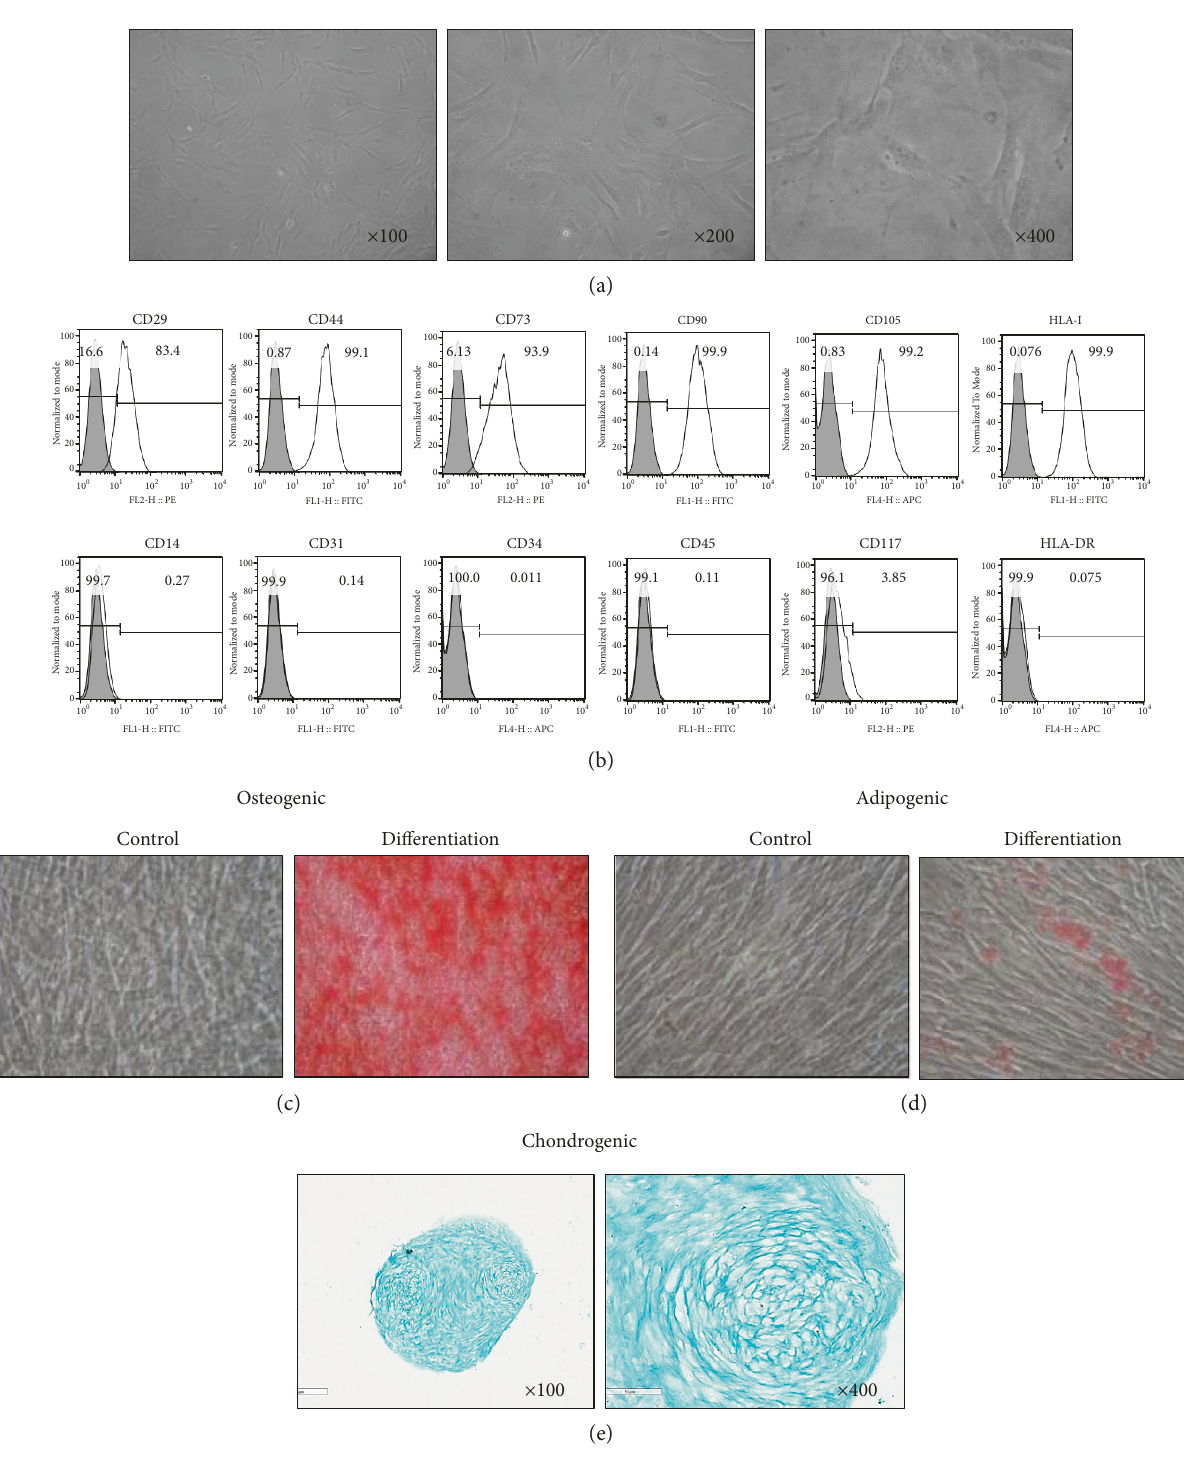
Figure 1: Primary isolation and characterization of DPSCs. Primary isolated DPSCs were cultured and characterized. (a) DPSCs showed typical MSC-like morphology at passage 3. (b) The expression of surface antigens was determined by FACS analysis. DPSCs were positive for MSC markers (CD29, CD44, CD73, CD90, and CD105) but negative for hematopoietic cell markers (CD14, CD34, CD45, CD117, and HLA-DR) and endothelial cell marker (CD31). DPSCs were induced in osteogenic or adipogenic medium for 21 days. (c) Alizarin red staining revealed deposits of calcium. (d) Oil red O staining showed lipid vacuoles. (e) Alcian blue staining con fi rmed chondrogenic di ff